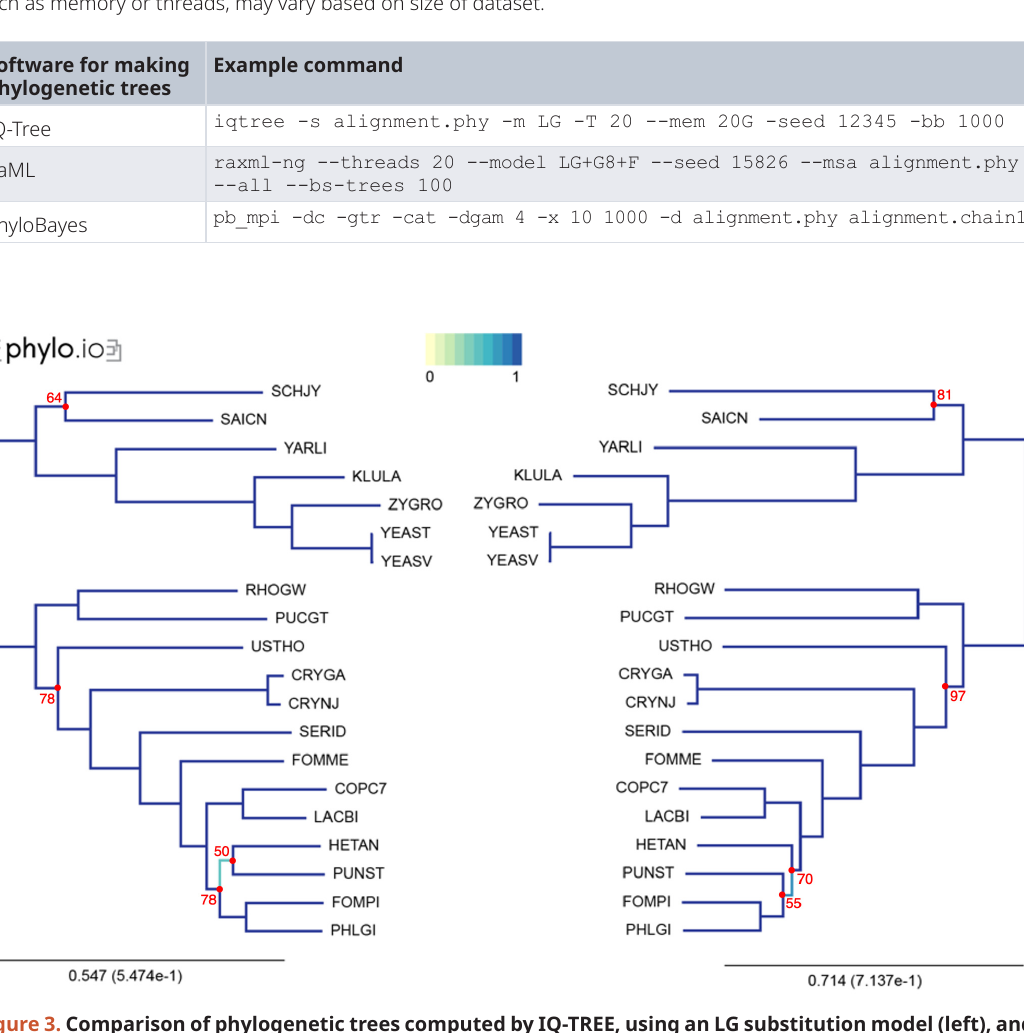
Figure 3. Comparison of phylogenetic trees computed by IQ-TREE, using an LG substitution model (left), and RAxML, using an LG substitution model, a discrete Gamma model of rate heterogeneity with 8 categories, and empirical amino-acid frequencies (right). Trees were computed with 20 yeast species present in OMA. The leaves of the trees are the UniProt 5-letter species codes. The following export options were used: Minimum species coverage: 1, Maximum nr of markers: -1 (uncapped). 168 marker genes were exported. Visualization was done with phylo.io; different shades of blue show variations in topology. Bootstrap values are reported in red for each bipartition with a bootstrap <100.